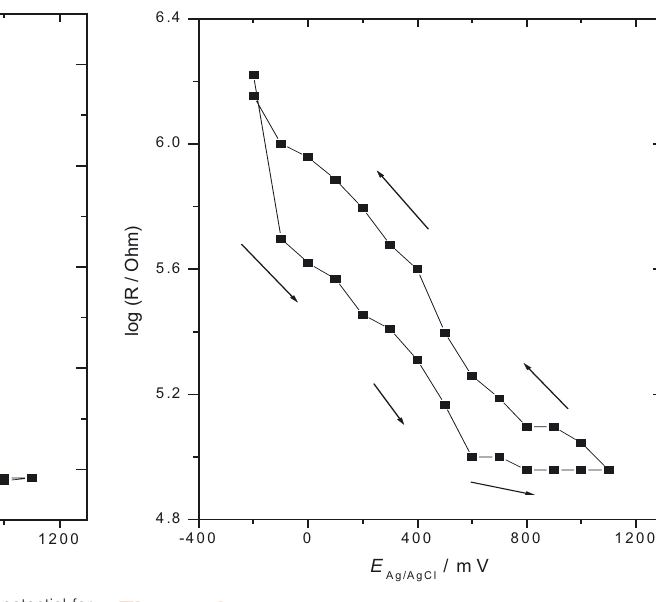
Figure 5. Plot of resistance versus applied electrode potential for P3MPy prepared potentiodynamically by cycling the po- tential (100 cycles) from -0.20 < E solution of 0.038 M 3MPy in acetonitrile + 0.05 M LiClO in a solution of acetonitrile + 0.05 M LiClO